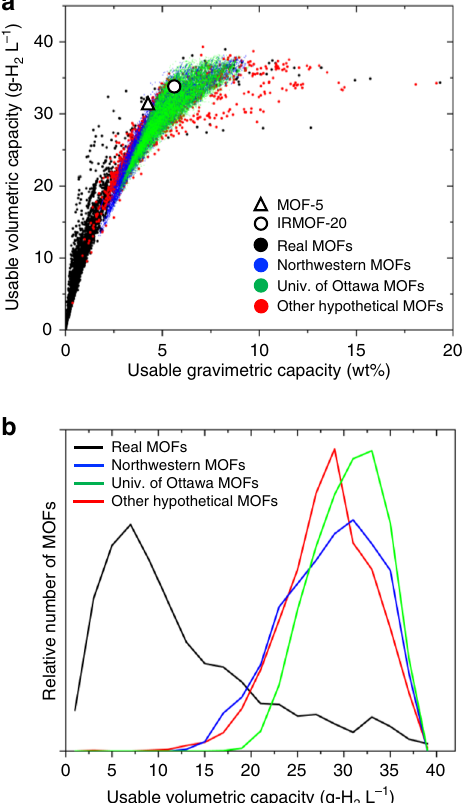
Fig. 1 High-throughput screening of MOFs. a Calculated usable hydrogen capacities of 43,777 MOFs compared to the measured capacity of IRMOF- 20 (5.7 wt.%, 33.4 g-H 2 L − 1 ) and MOF-5 (4.5 wt.% and 31.1 g-H 2 L − 1